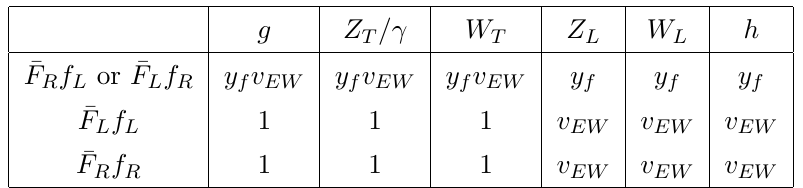
Table 1 . Summary of Yukawa and isospin suppression(-lifting) in three-body annihilation processes (cid:31)(cid:31) B (cid:22) Ff for various (cid:12)nal state boson B and fermion combinations. Entries ! processes that potentially can lift both Yukawa and isospin suppression of the two-body process. Entries y f can lift isospin suppression but are still suppressed by the Yukawa coupling, while / those v EW can lift Yukawa suppression but are still suppressed by (cid:14) v = v EW =m (cid:31) for large m (cid:31) . / sertion approximation, and is associated with a chirality (cid:13)ip along with a suppression factor m f y f v EW . In addition, longitudinally polarized gauge bosons W L =Z L can be replaced / by the corresponding Goldstone bosons G (cid:6) ; G 0 by virtue of the Goldstone boson equiva- lence theorem, cf. eqs. (2.7){(2.8) below. All (cid:12)nal states thus have de(cid:12)nite SU(2) L